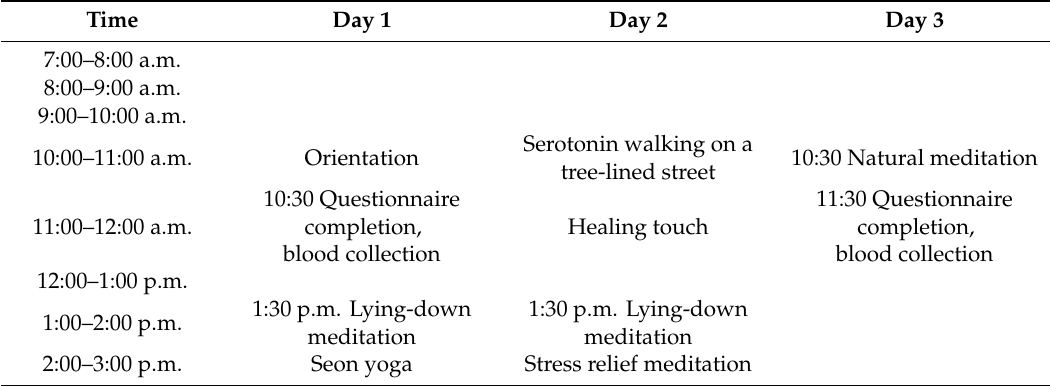
Table 3. Forest therapy program schedule for the urban (control) group.